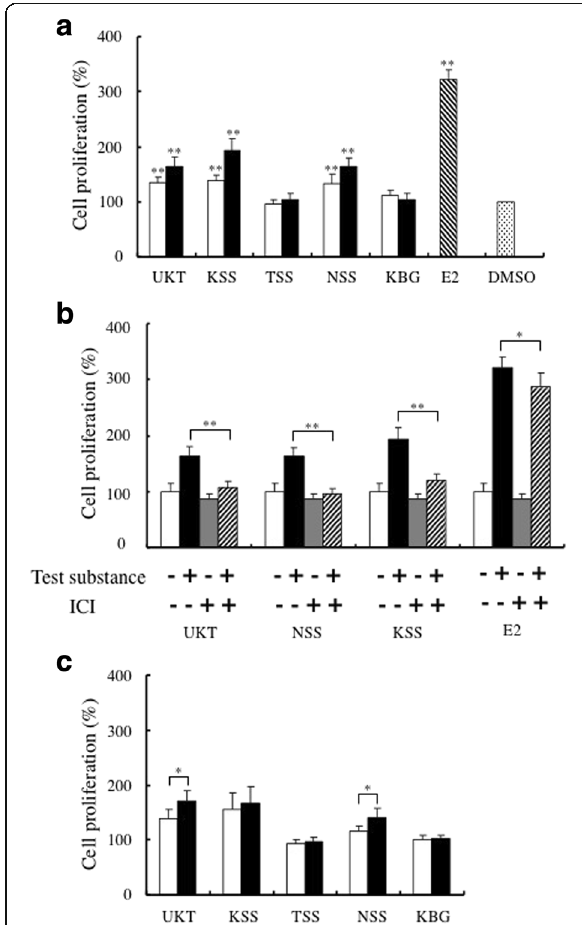
Fig. 1 The cell proliferation activity induced by Japanese herbal medicines. a MtT/Se cells were incubated with 50 μ g/ml (white columns) or 100 μ g/ml of each Japanese herbal medicine (black columns) or 10 − 7 M of E2 for 6 days. Cell proliferative activity is shown as a percentage compared with that induced by DMSO alone in the MTT assay. **significantly increased compared with the activity induced by DMSO, p <0.01. b Cells were treated with 10 nM ICI alone or a combination of 10 nM ICI and 100 μ g/ml of UKT , KSS , or NSS or 10 − 7 M E2 for 6 days. White columns: ICI( − )test substance( − ); blank columns: ICI( − )test substance(+); gray columns: ICI(+)test substance( − ); diagonal columns: ICI(+)test substance(+). **significantly inhibited the induction of cell proliferation compared with herbal medicines or E2 alone, p <0.01; * p <0.05. c The cell proliferation induced by metabolized Japanese herbal medicines. The Japanese herbal medicines were treated with the rat S9 fraction, and the proliferative activity induced by each Japanese herbal medicine (100 μ g/ml, black columns) was compared with that induced by the unmetabolized medicine (white columns). *significantly increased compared with the activity of the unmetabolized medicine, p